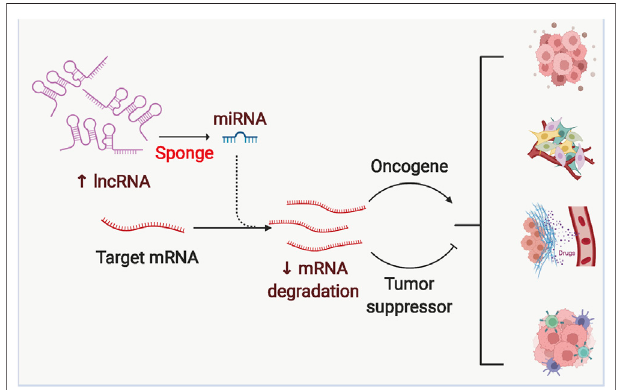
FIGURE 4 | The competing endogenous RNA mechanism of Long noncoding RNAs (lncRNAs). LncRNAs can inhibit the degradation of downstream mRNAs by binding different miRNAs, which in turn regulates the expression of pro- or oncogenes, ultimately leading to malignant progression of